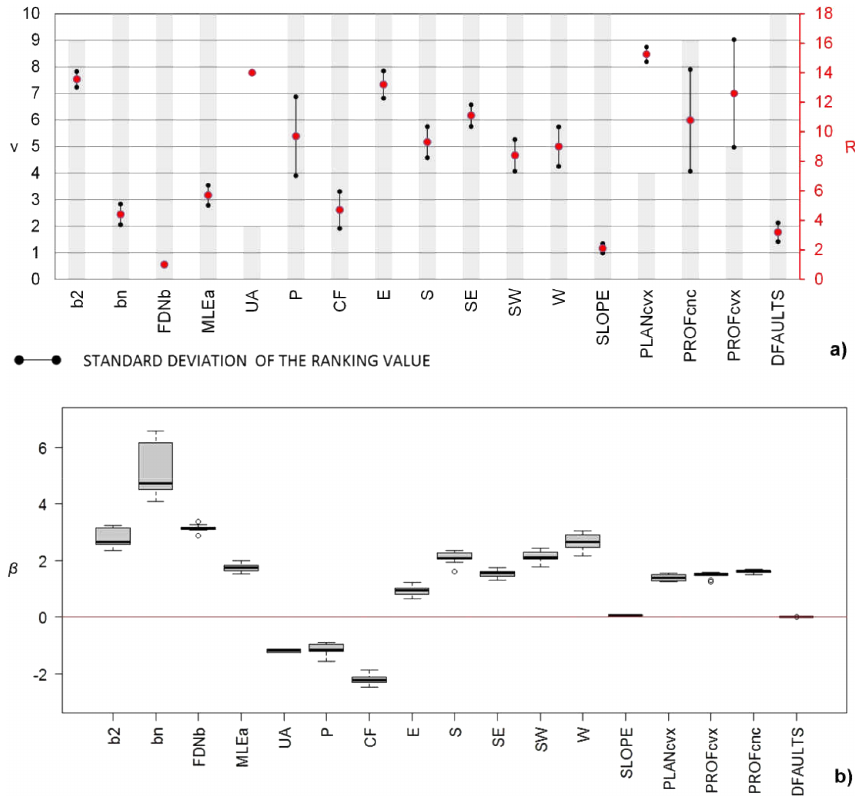
Figure 10. Selected variables for the 2009 suite of models: (a) ranking and frequency; (b) β values. For purposes of representation, the coefficients of the topographic curvatures are reported as log β values.